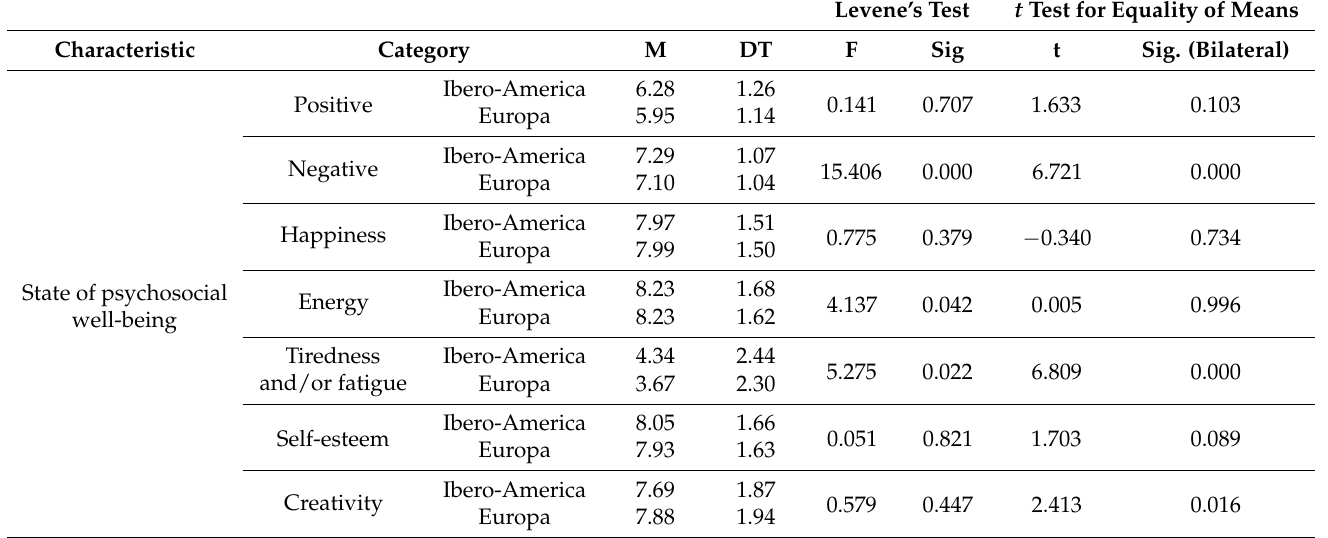
Table 4. State of psychosocial well-being according to the area of residence. Levene’s Test t Test for Equality of